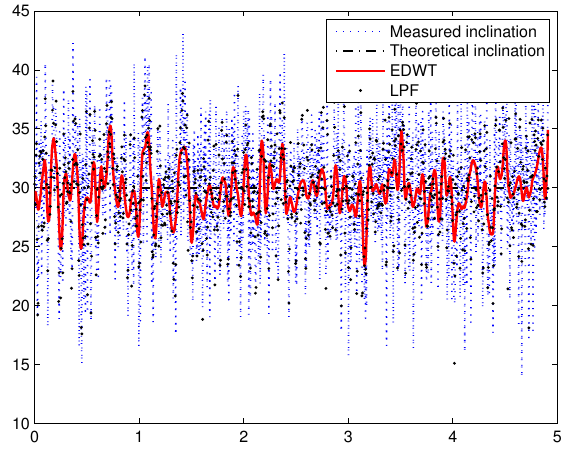
Figure 6. Comparison of inclination angles before and after filtering.